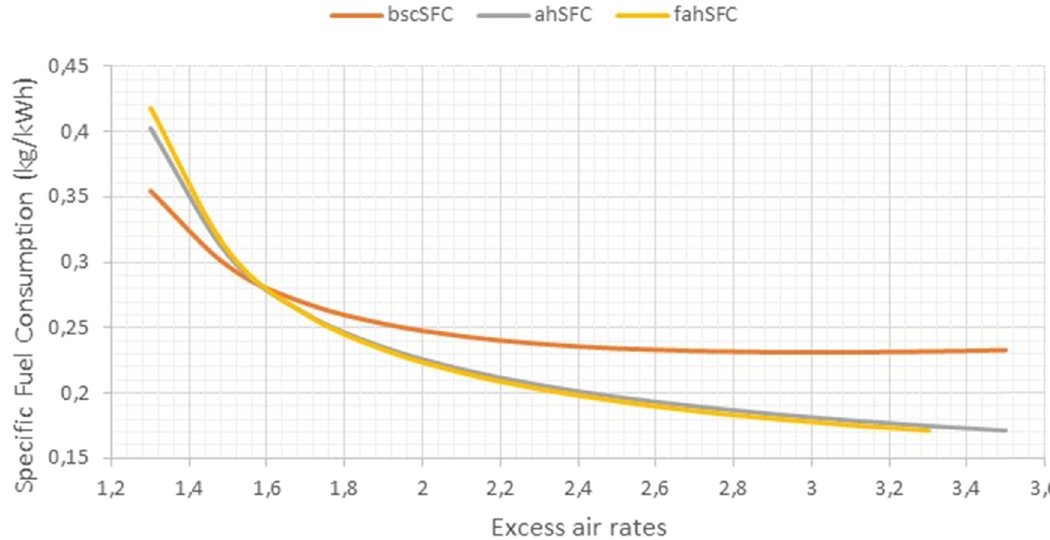
Figure 9: Variation of the SFC with excess air rates for bsc, ah and fah cogeneration plants.